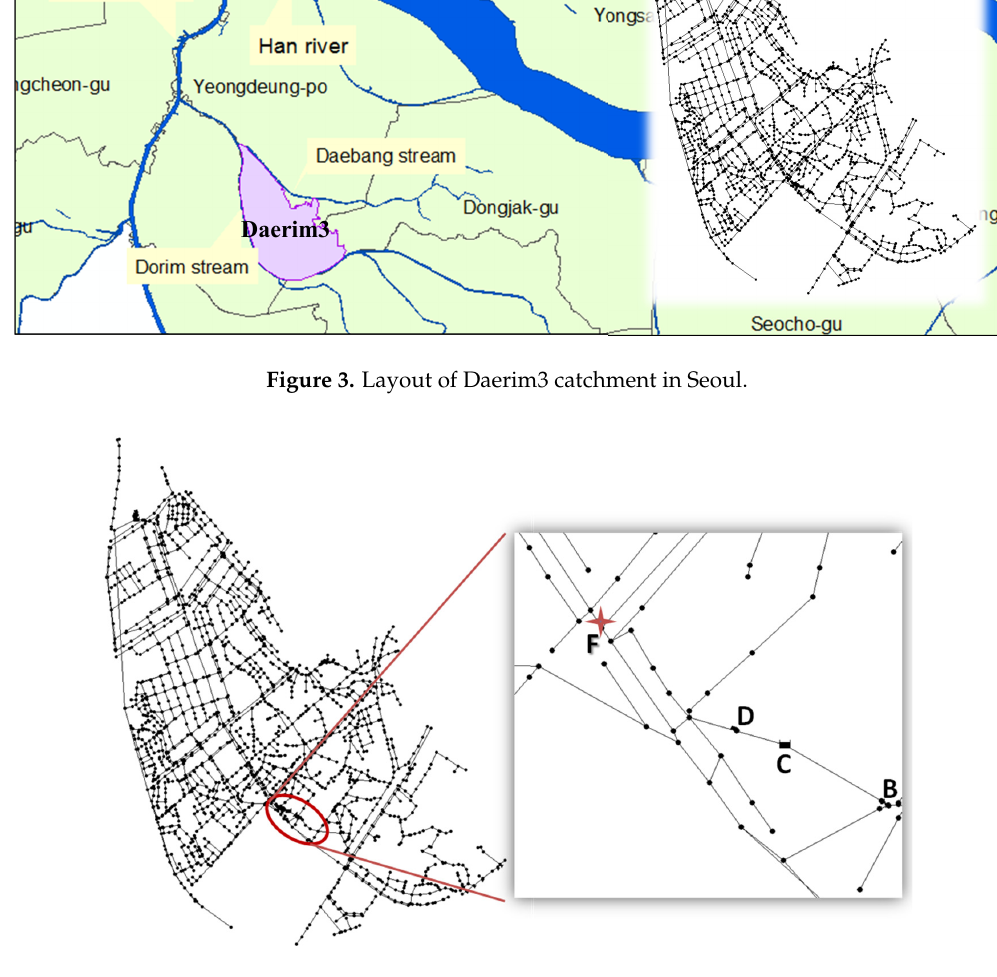
Figure 4. Daerim3 conduit system and layout of Daerim3 detention Figure 4 . Daerim3 conduit system and layout of Daerim3 detention reservoir. Table 1 . Parameters of the detention reservoir facilities.